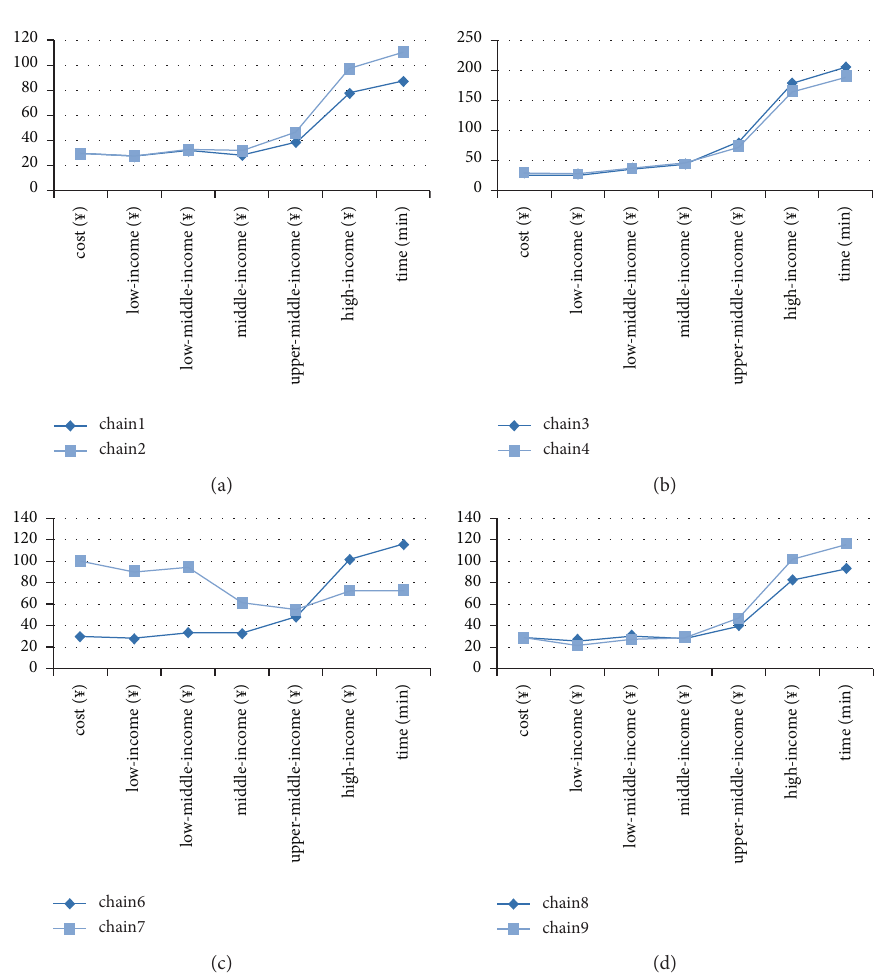
Figure 3: Comparison of the harvest for similar types of trip